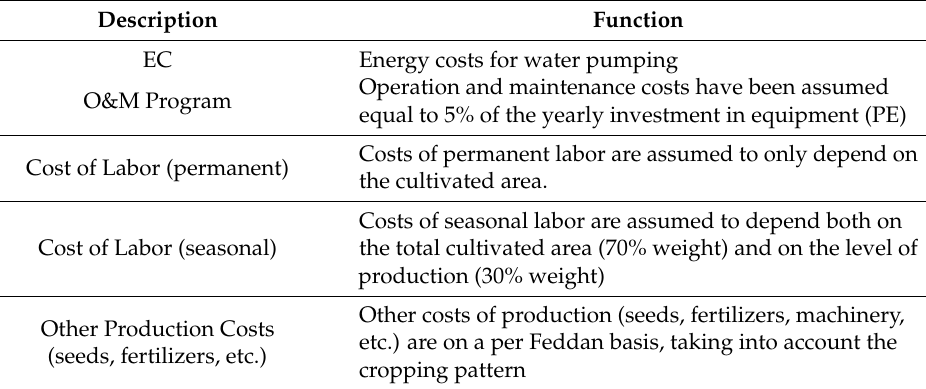
Table A4. Running Cost Categories under Scenario A0.